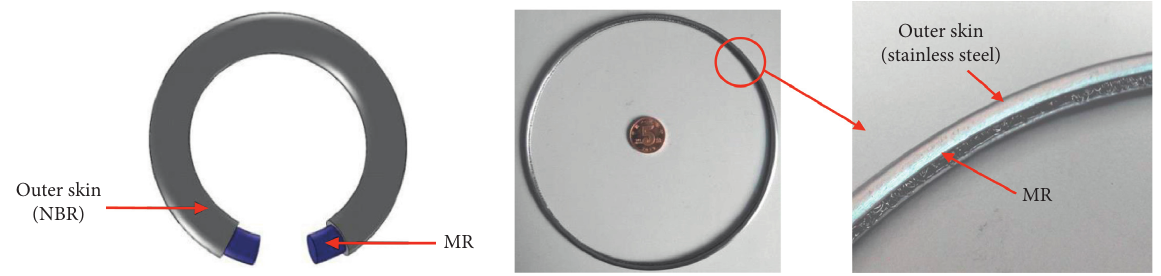
Figure 1: Metal rubber seals [7,